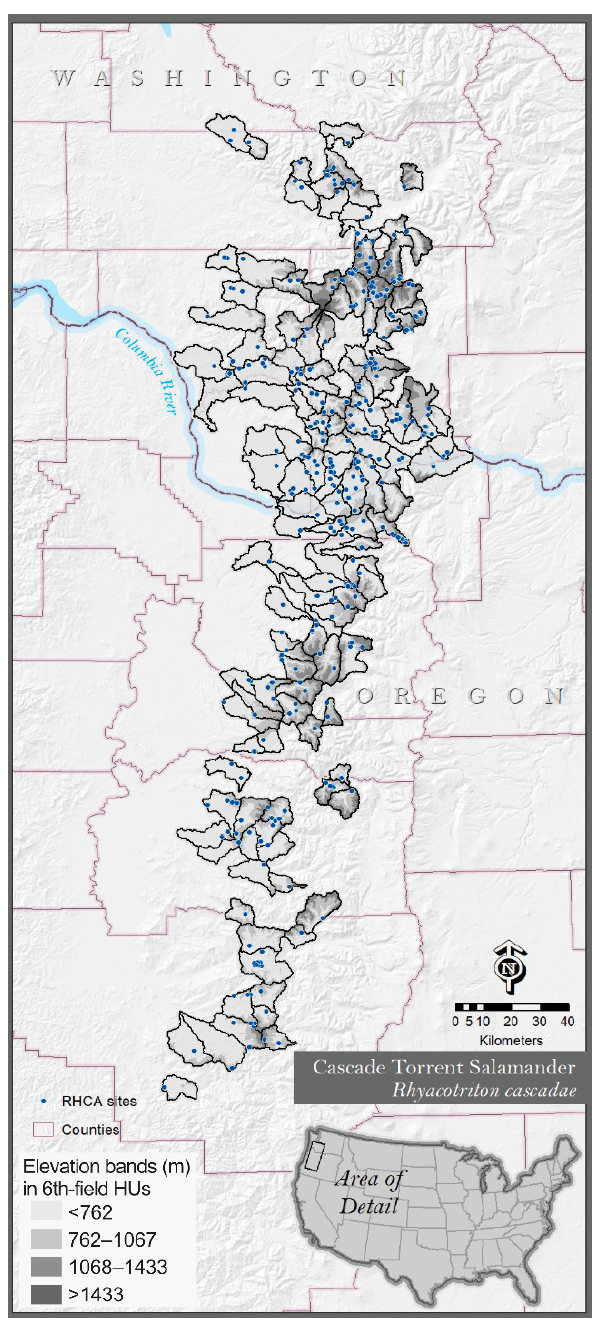
Figure 4. Landscape area of the Oregon and Washington, USA western Cascade Range where the effect of modeled climate change in year 2085 on headwater streamflows was projected. Polygons are 6th-field watersheds (HUs = hydrologic units) which have one or more known sites of the Cascade torrent salamander ( Rhyacotriton cascadae ; RHCA), a sensitive species associated with discontinuous headwater streams. Shading depicts elevation bands, defined on map.